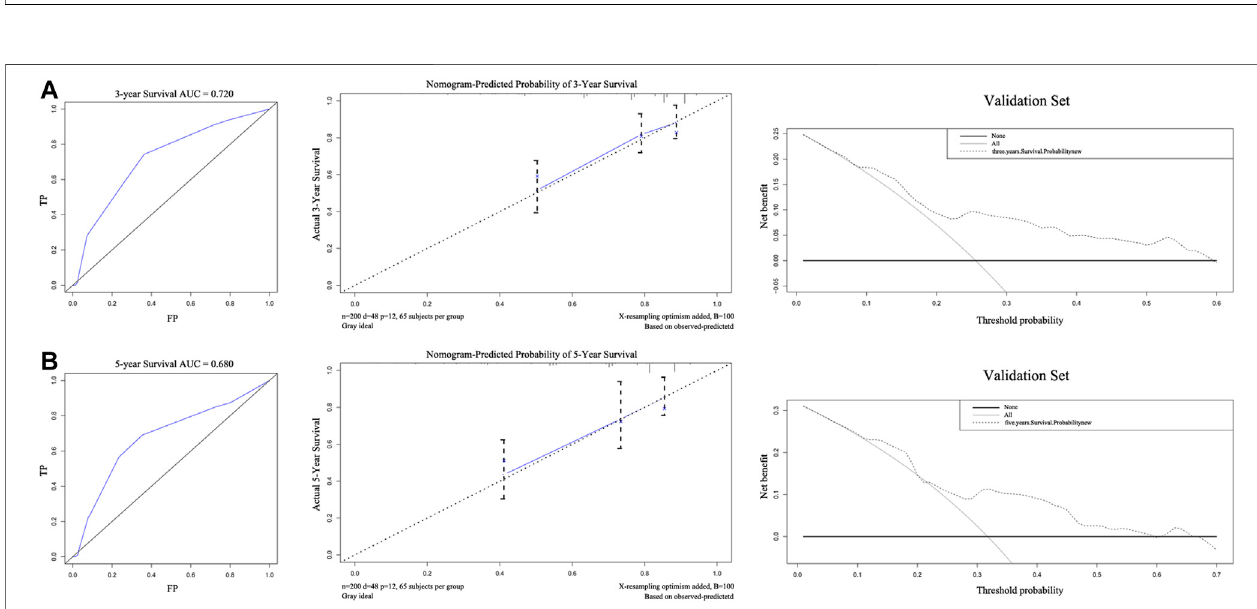
FIGURE 4 | The areas under the receiver operating curves, Calibration plots, and decision curve analysis of OS associated nomograms in validation set. The validation set of 3-years (A) and 5-years (B) , respectively. OS, overall survival.